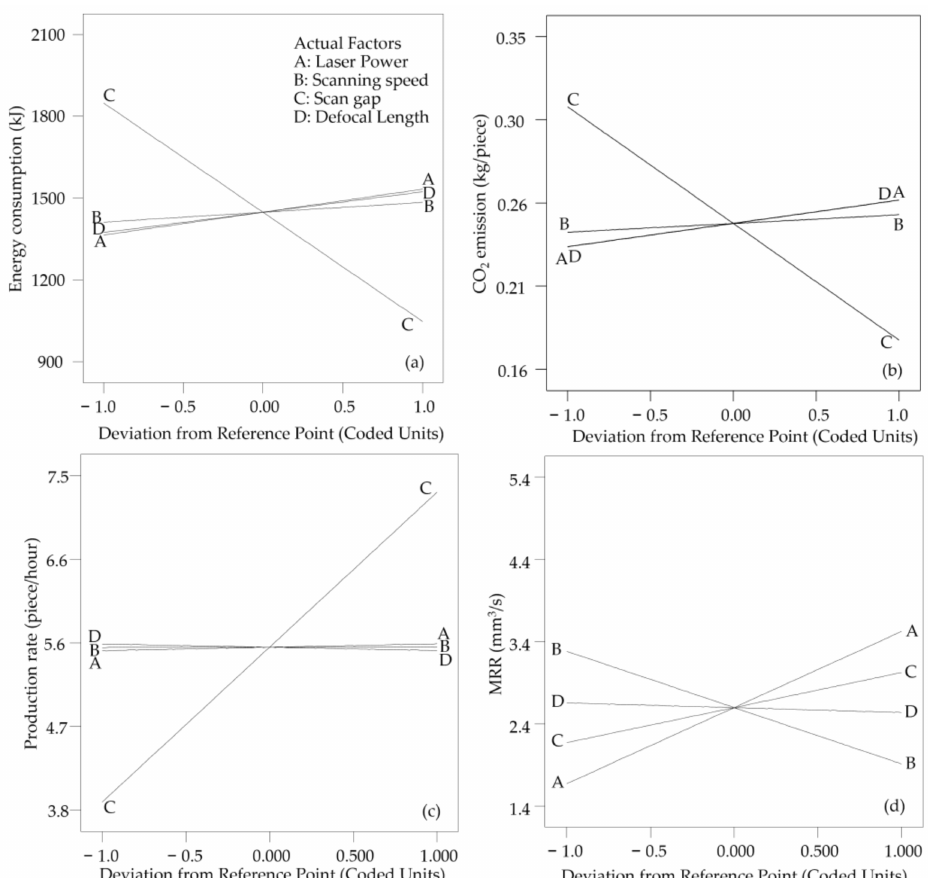
Figure 3. Perturbation plot ( a ) Energy consumption ( b ) CO 2 emission ( c ) Production rate ( d )